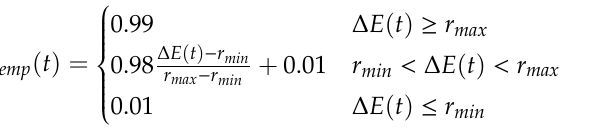
curve after filtering and the corresponding temporal weights; ( d ) time-frequency weights that combine